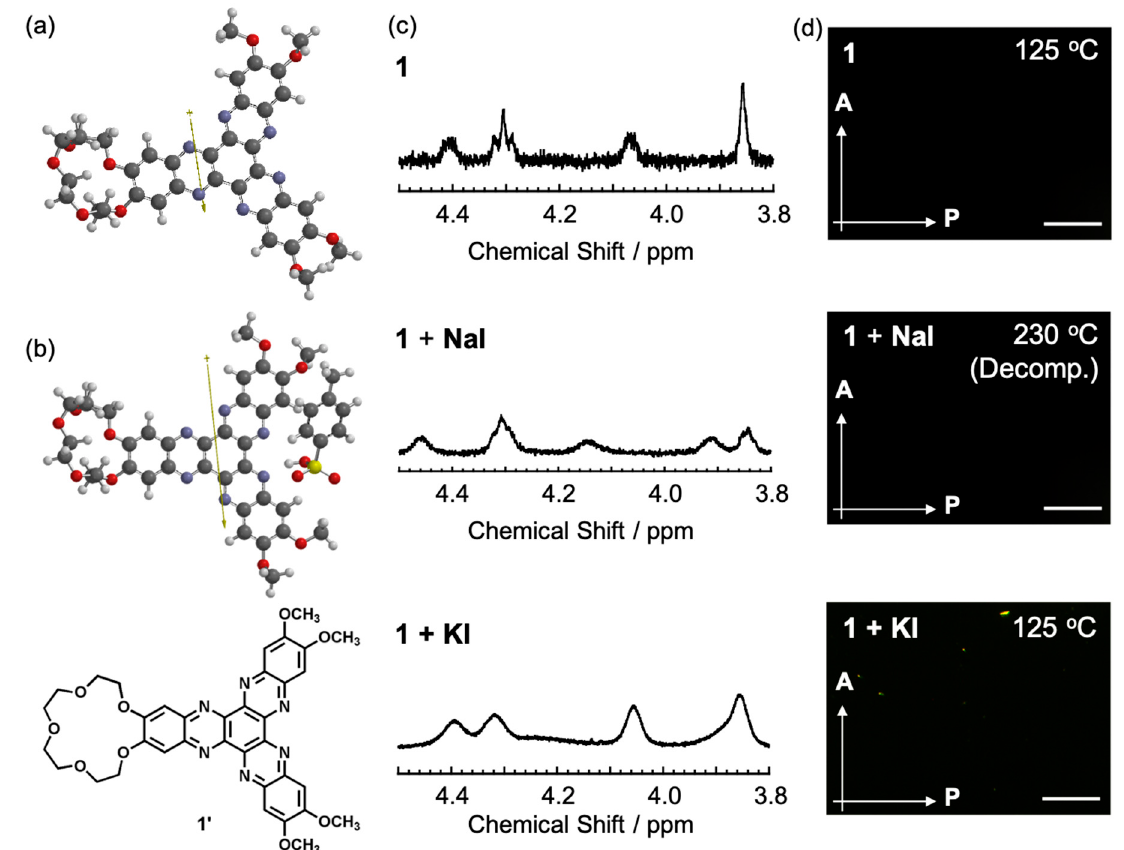
Figure 6. Density functional theory (DFT) calculations by using 1’ ( a ) and complex 1’ of with BSA ( b ). Arrows indicate dipole moments. ( c ) 1 H NMR spectra and of 1 12 ( top ) and 1 12 with NaI ( middle ) and KI ( bottom ) in the range of crown-ether moieties and ( d ) POM observations of 1 12 ( top ) and 1 12 with NaI ( middle ) and KI ( bottom